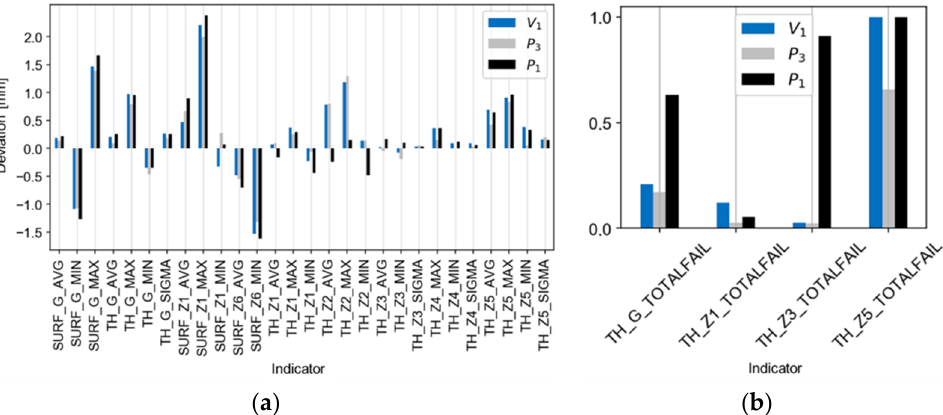
Figure 14. Comparison of the results of the V 1 trial with the best and worst results of the experiments P 3 and P 1 for the indicators of ( a ) deviation and of ( b ) tolerance.